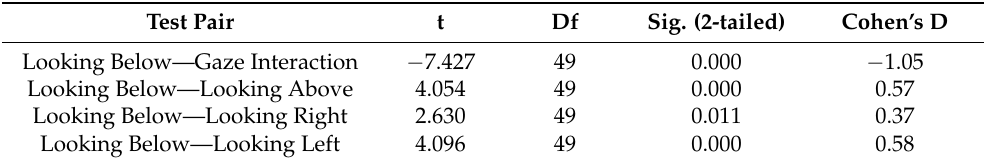
Table 4. Pair sample independent t-test to show the difference between looking below sub-behavior and all other